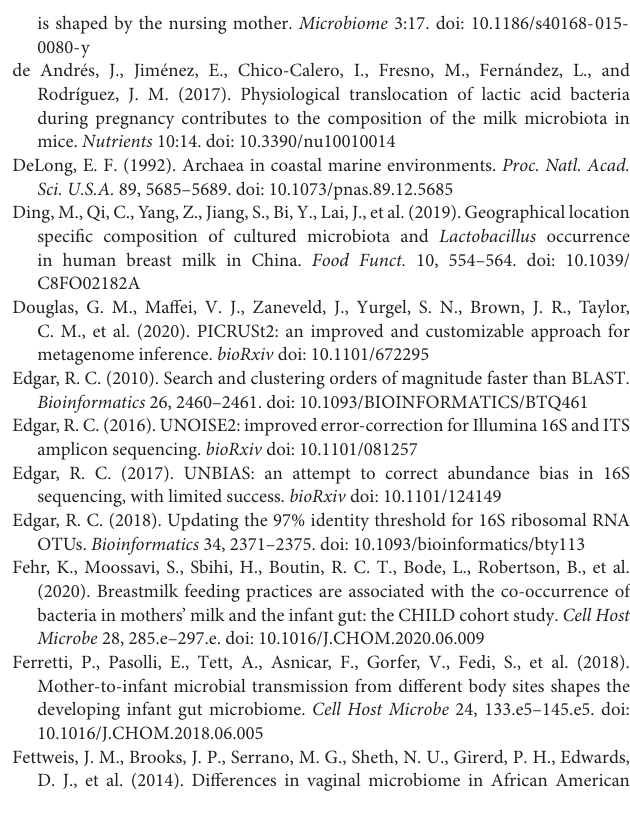
Supplementary Figure 1 | Circular maximum likelihood phylogenetic tree based on ZOTUs representative sequences of Lactobacillus spp. detected in all samples of breast milk (BM), infant feces(IF), and maternal feces(MF). The bars in the outer band represent the average relative abundances of ZOTU. Supplementary Figure 2 | The Lactobacillus community composition and relative abundance in each of 25 mother-infant pairs with different infant ages. Each panel shows relative abundances of the 19 Lactobacillus species and/or species groups, with each bar representing a sample and each colored bar segment representing the relative abundance of the species and/or species group indicated in the colour key below. Supplementary Figure 3 | Rep-PCR fingerprints of Lactobacillus spp. isolated from breast milk (BM), maternal feces(MF) and infant feces(IF) of partial mother-infant dyads, using primer BOXAIR. Isolates highlighted in bold indicated identical Lactobacillus strains which were recovered from at least two of the three ecosystems. Supplementary Table 1 | Lactobacillus species-level zero radius operational classification units identified in all maternal and infant samples. Supplementary Table 2 | Taxonomy of Lactobacillus isolates in all maternal and infant samples based on 16S rRNA gene sequence alignments with Gen Bank ( ≥ 97% sequence similarity). Supplementary Table 3 | Occurrence and composition of Lactobacillus species in all maternal and infant